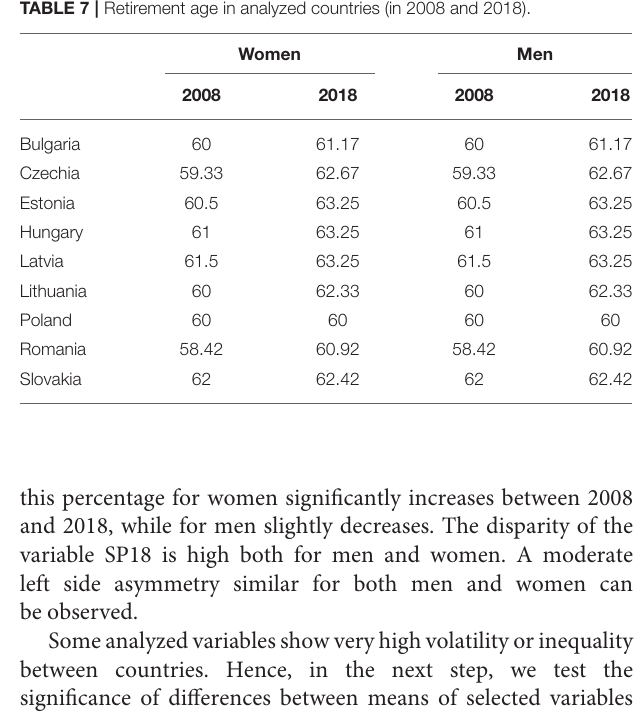
TABLE 4 | KILM 11—descriptive statistics for the years 2008 and 2018.